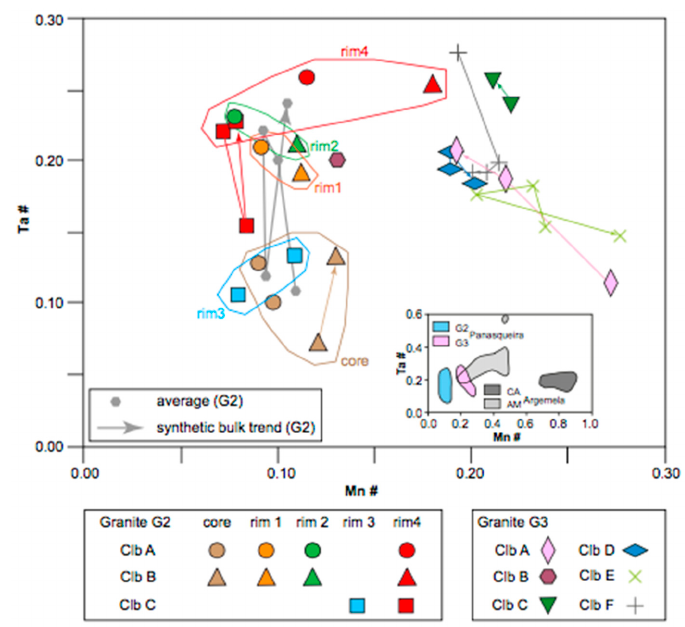
Figure 22. Panasqueira columbite-tantalite in the Ta / Ta + Nb ( = Ta#) vs. Mn / Fe + Mn ( = Mn#) classification diagram. Inset: comparison with the magmatic columbite-tantalite from the nearby Argemela RMG (CT1 [55]: CA, Cabeço de Argemela cupola; AM, Argemela Mine RMG, and dike).